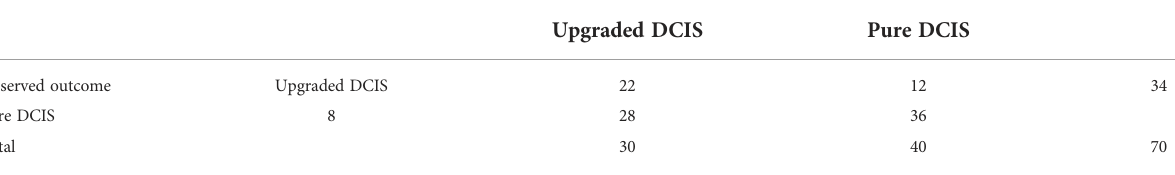
TABLE 4 Confusion matrix of the radiomics model in the test